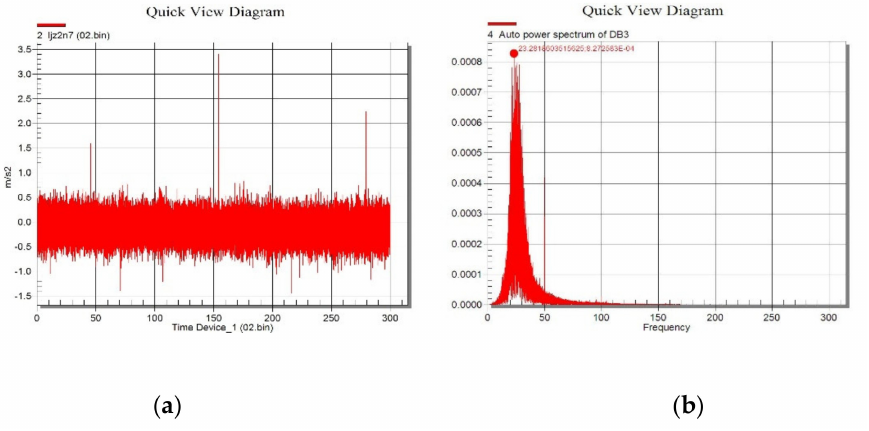
Figure 6. ( a ) The vertical acceleration time history curve; ( b ) the measured pier vertical fundamen- tal